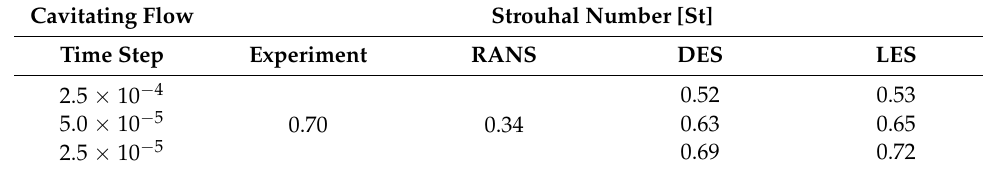
Table 6. Comparison of Strouhal number according to experiment and turbulence model.